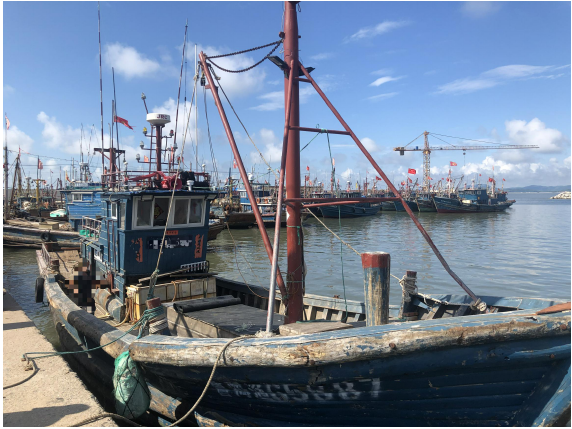
Figure 10. Ship of the mooring alignment